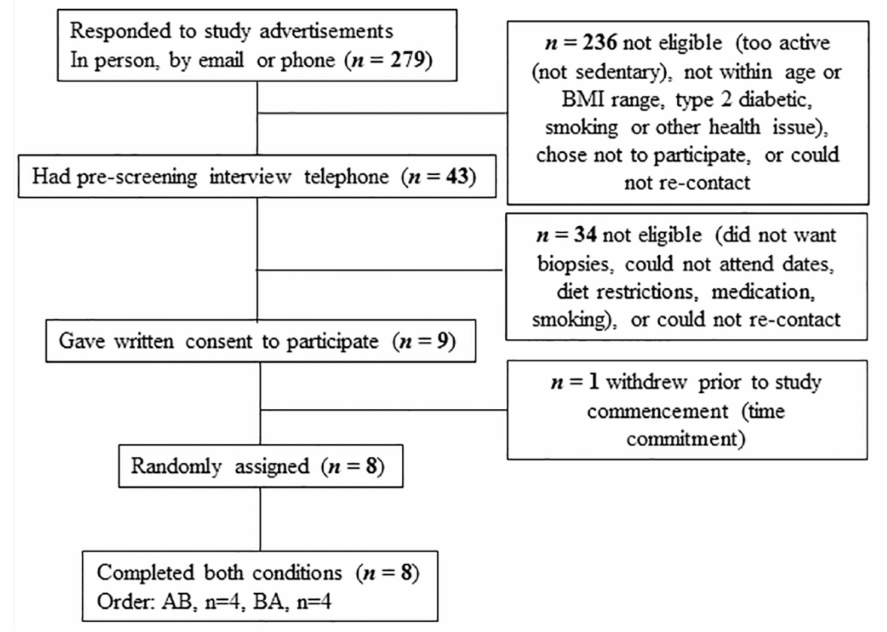
Figure 2. Consolidated Standards of Reporting Trials (CONSORT) flow diagram of participant